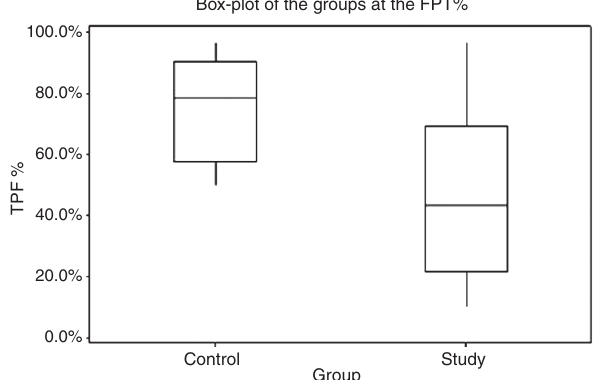
Control group and study group performance at the Frequency Pattern